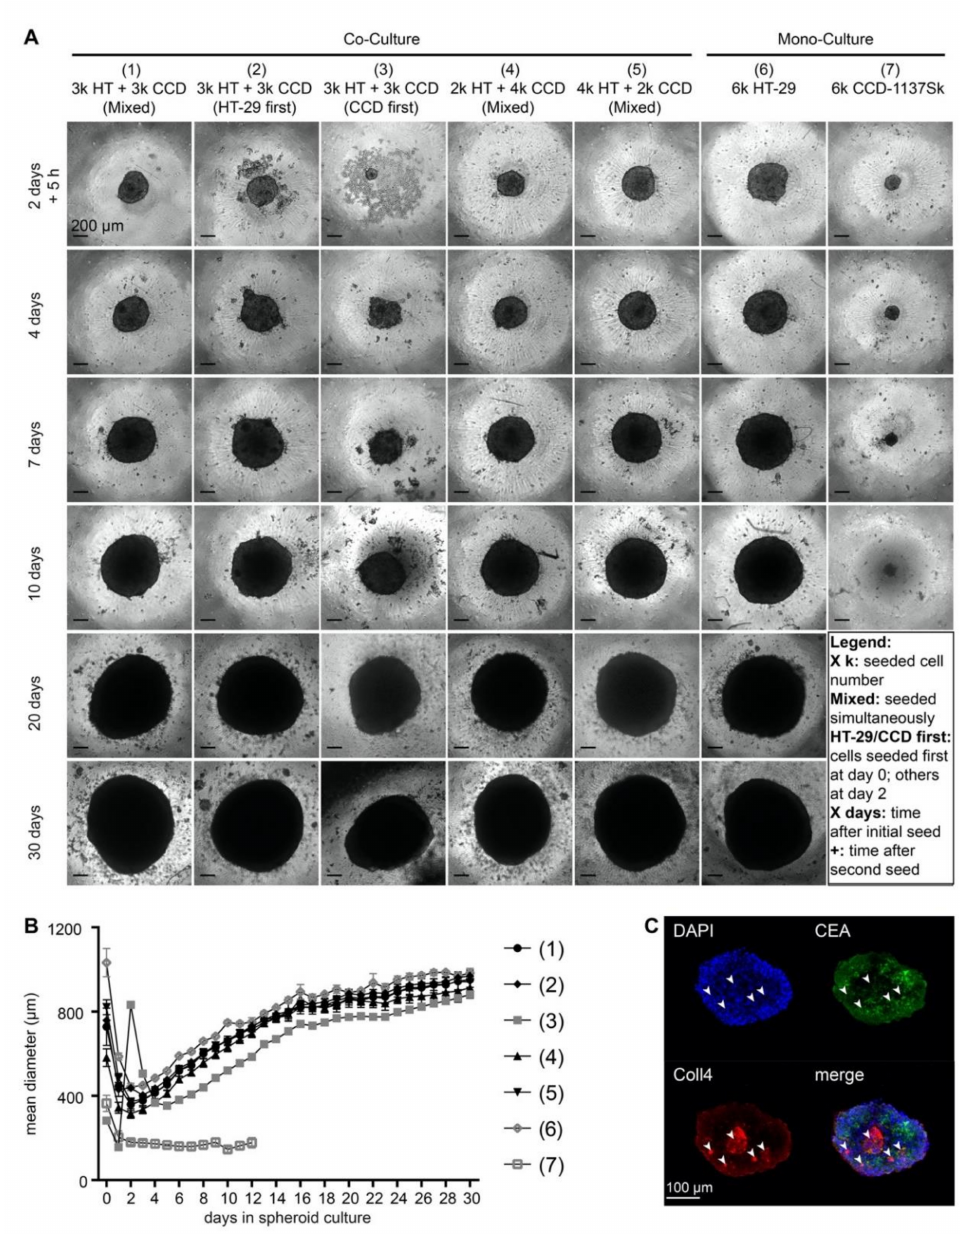
Figure 4. Growth of HT-29 spheroids is una ff ected in the presence of CCD-1137Sk cells. Human HT-29 or CCD-1137Sk cells were seeded into ultra-low attachment plates to form spheroids, following di ff erent seeding orders (mixed, HT-29 first or CCD-1137Sk first) and cell numbers (ranging from 2000 to 6000 cells per type) as indicated. From 0 to 30 days in culture, brightfield images were taken to perform spheroid-size analysis based on the mean diameter ( A–B ). Additionally, co-culture spheroids with 250 HT-29 cells together with simultaneously seeded 500 CCD-1137Sk cells were fixed after four days and stained with DAPI as well as with anti-CEA and anti-Coll4 antibodies as markers for nuclei, HT-29 cells, and fibroblasts, respectively ( C ). ( A ) Representative brightfield images of HT-29 and CCD-1137Sk mono- and co-culture spheroids seeded in di ff erent ratios and orders, as depicted. ( B ) Graph shows a quantitative analysis of the mean diameters of mono- and co-culture spheroids at di ff erent time-points as indicated. Mean + SEM ( n = 5–9 experiments). ( C ) Representative optical slice of DAPI (blue), anti-CEA (green), and anti-Coll4 signals (red). Arrowheads, exemplary clusters of Coll4-positive areas. Bottom right panel shows an overlay image of all three